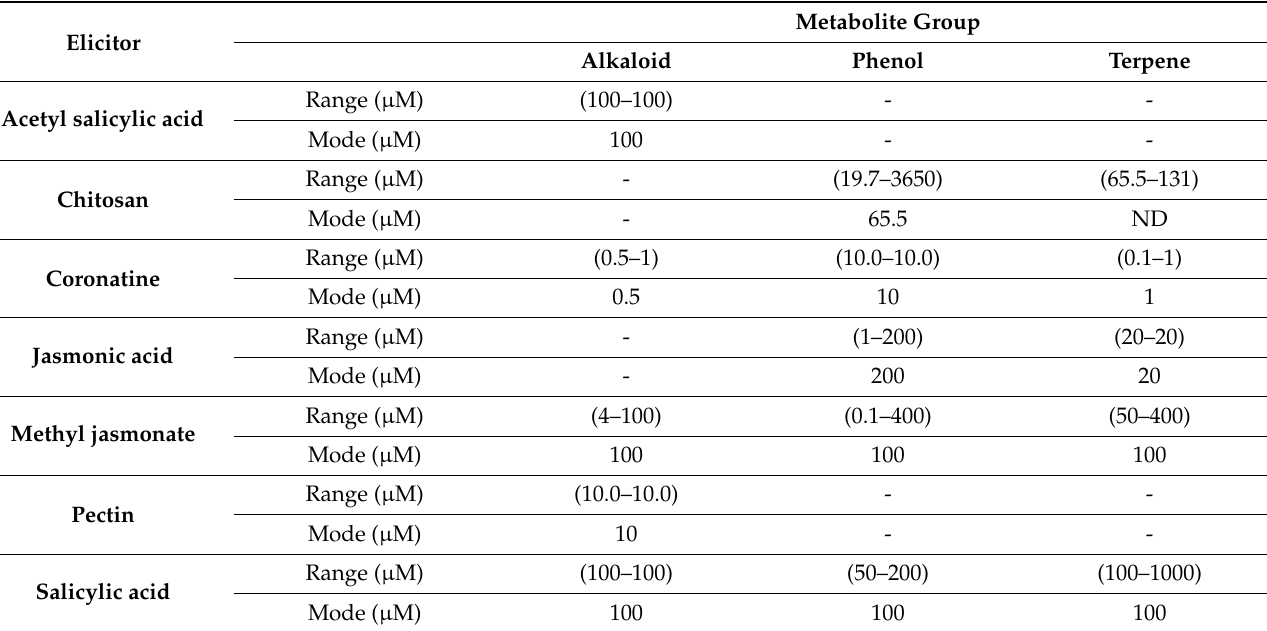
Table 4. Concentration range ( µ M) of elicitors applied in hairy roots according to the metabolite group, from 2010 to 11 January 2022.